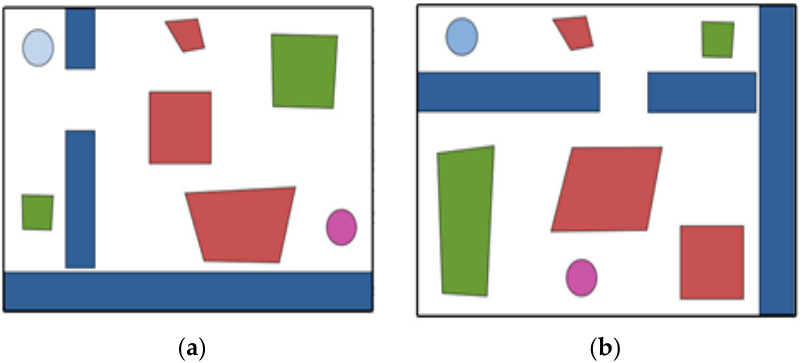
Figure 12. Two different target environments that users are required to design: ( a ) A Type; ( b ) B Type.